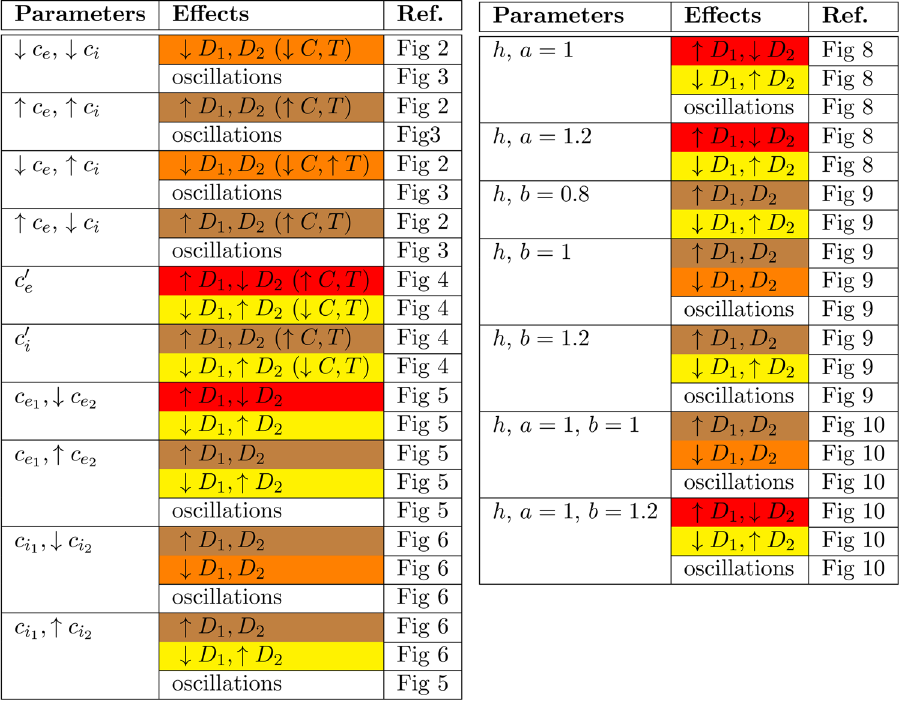
Figure 11. Summary table of all observed effects when changing different